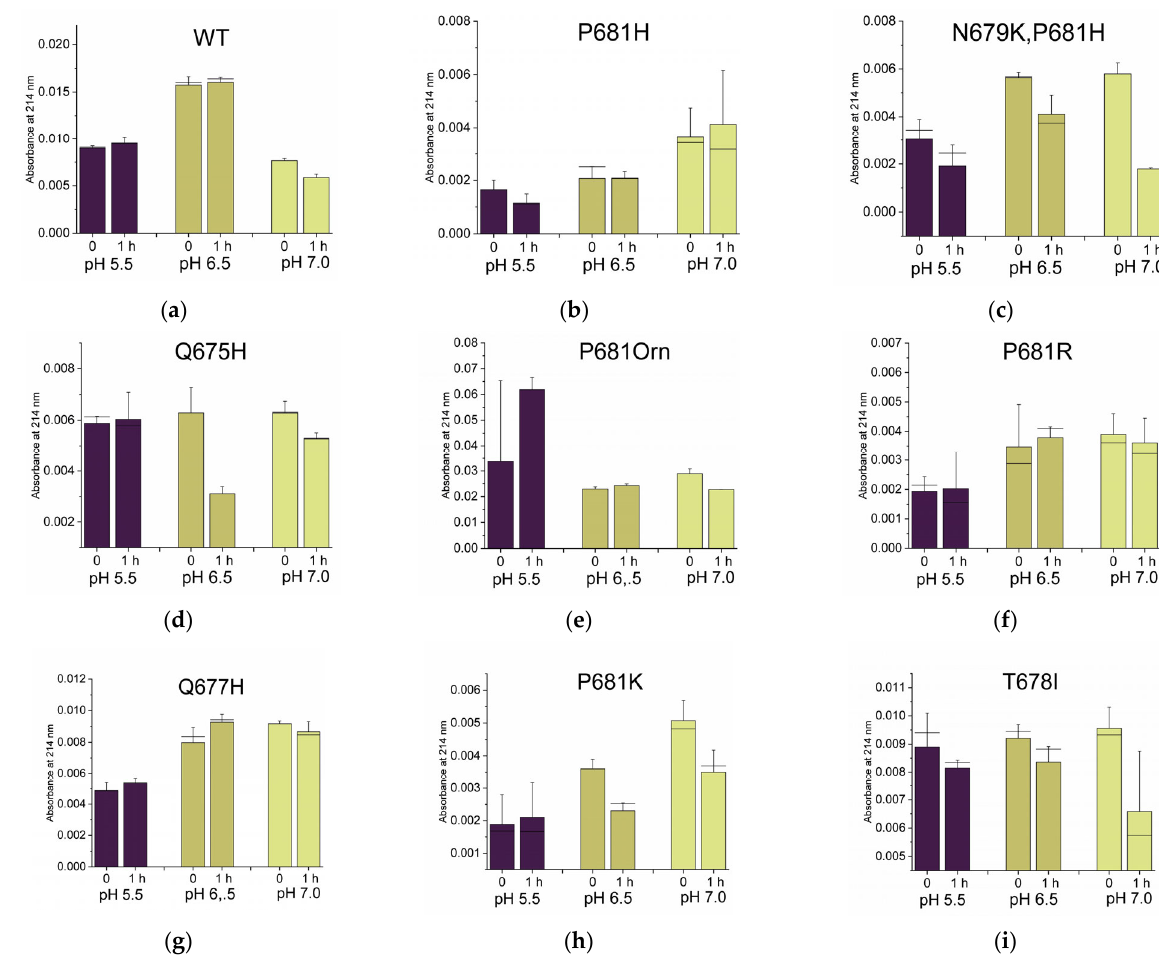
Figure 7. In vitro digestion of peptides mimicking the cleavage site (673–689) of SARS-CoV-2 S WT and mutants. Peptides were incubated with sFur as described in the Materials and Methods section. Areas relative to residual uncleaved peptide detectable by HPLC at 214 nm are reported. Experiments were performed as triplicates. Mean values and error bars are reported; ( a ) WT peptide; ( b ) P681H; ( c ) N679K/P681H; ( d ) Q675H; ( e ) P681Orn; ( f ) P681R; ( g ) Q677H; ( h ) P681K; ( i ) T678I mutant peptides.